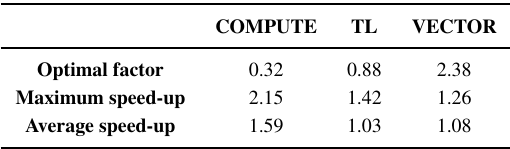
Table 3. Speed-up compared Equally Distributed